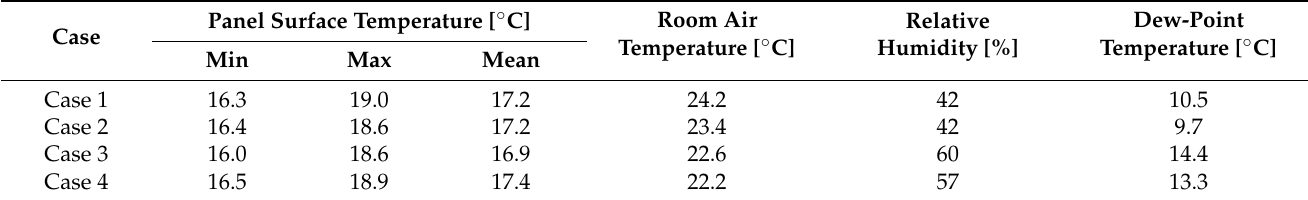
Table 4. Panel surface temperature and dew-point